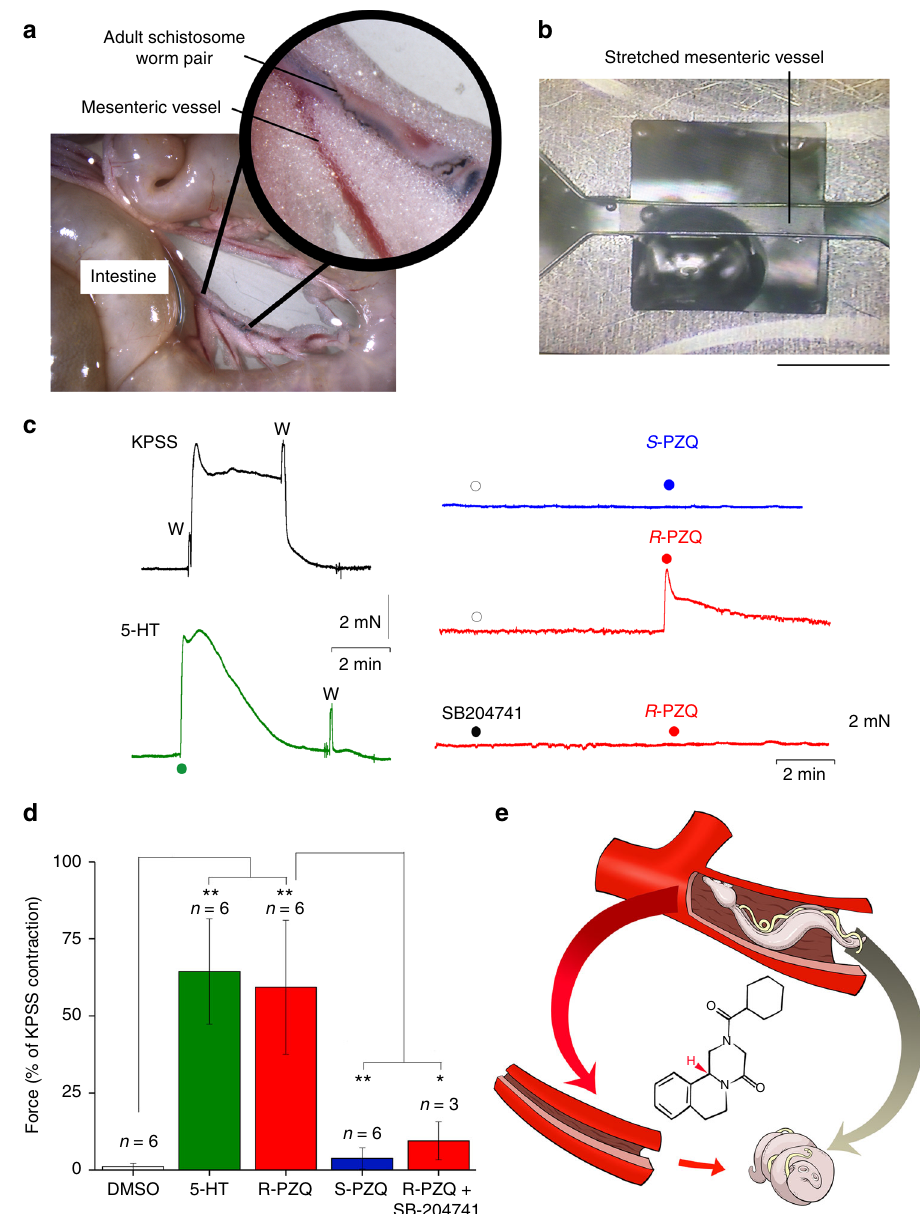
Fig. 3 (R)- PZQ constricts mouse mesenteric vasculature. a Image of mesentery surrounding mouse intestine, showing blood vessel containing a schistosome worm-pair (inset). b Representative image of a surgically isolated piece of mouse mesenteric artery held under tension between two clamped wires. Scalebar, 1 mm. c Changes in tension triggered by varied manipulations. Left, sustained contraction of vessels in KPSS and 5-HT (10 µ M). Right, tension in individual arteries incubated in the presence of vehicle (DMSO, open circle) or SB204741 (10 µ M, closed circle), and challenged with (R)- PZQ (50 µ M) or (S)- PZQ (50 µ M). W, wash; complete media exchange. Preincubation of strips with SB204741 (10 µ M) attenuated (R)- PZQ evoked vasoconstriction. d Cumulative data set from experiments reporting effects of ligands relative to KPS(S)-evoked contractile tension, concentrations of ligands: 5-HT (1 µ M), (R)- PZQ (50 µ M), (S)- PZQ (50 µ M), SB204741 (10 µ M). Replicate number for each measurement as indicated, where individual measurements re fl ect the response from a naïve artery isolated from different mice. Data are presented as mean ± s.d. Probability, p < 0.05 (*), p < 0.01 (**). e Schematic model (not to scale) depicting (R)- PZQ action on both parasite (contraction) and host vasculature (contraction, increased